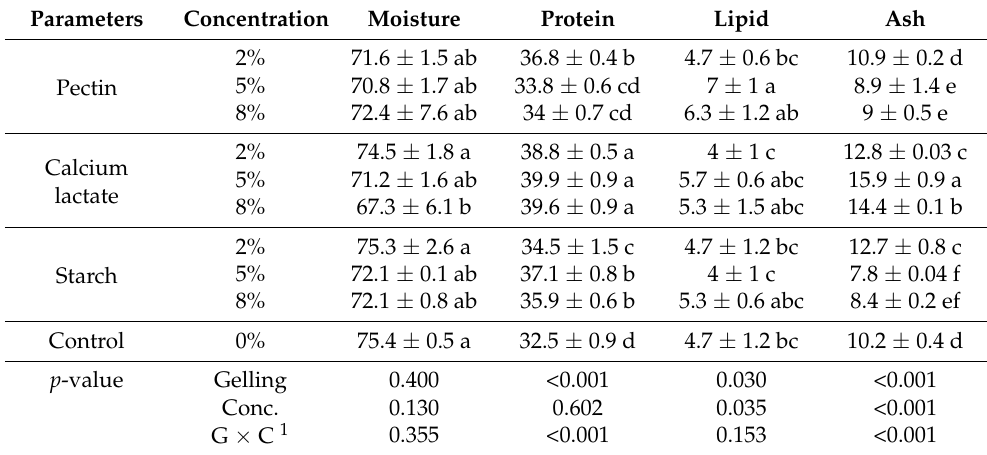
Table 4. Proximate compositions of different gel-based feeds.